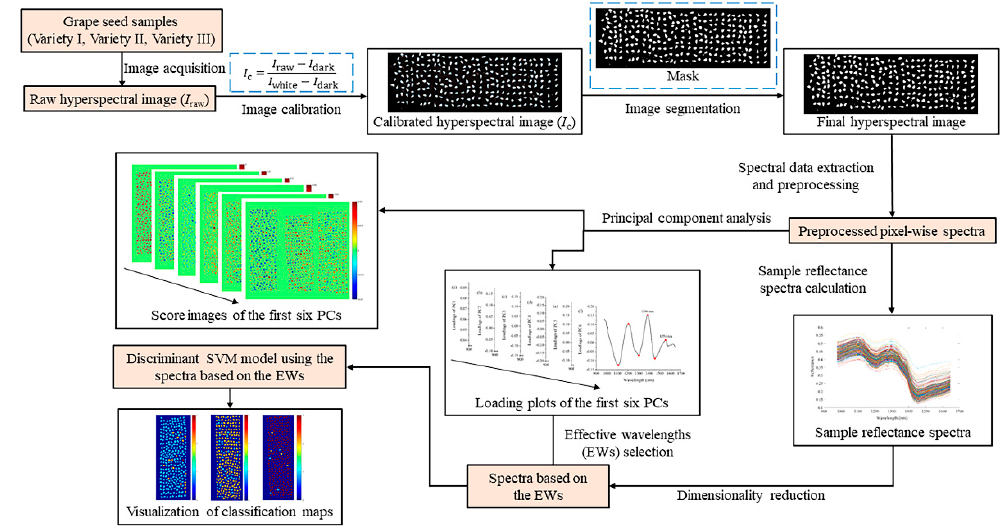
Figure 5. Main steps for analyzing hyperspectral images and establishing the discriminant model for grape seed varieties. EW, effective wavelength.